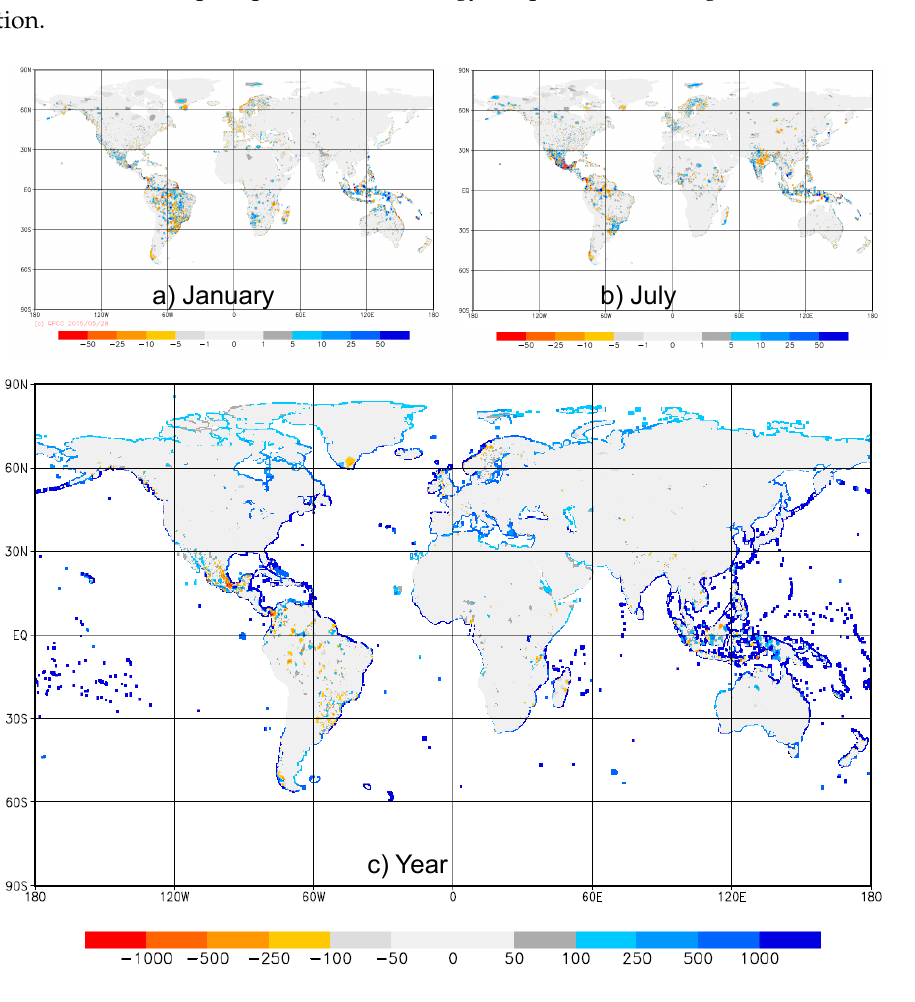
Figure 4. Differences (mm) between the 2015 release of GPCC’s precipitation climatology and the 2011 release for ( a ) January; ( b ) July and ( c ) for the year. The map for the year ( c ) also highlights the differences of the land masks (dark blue) between the two